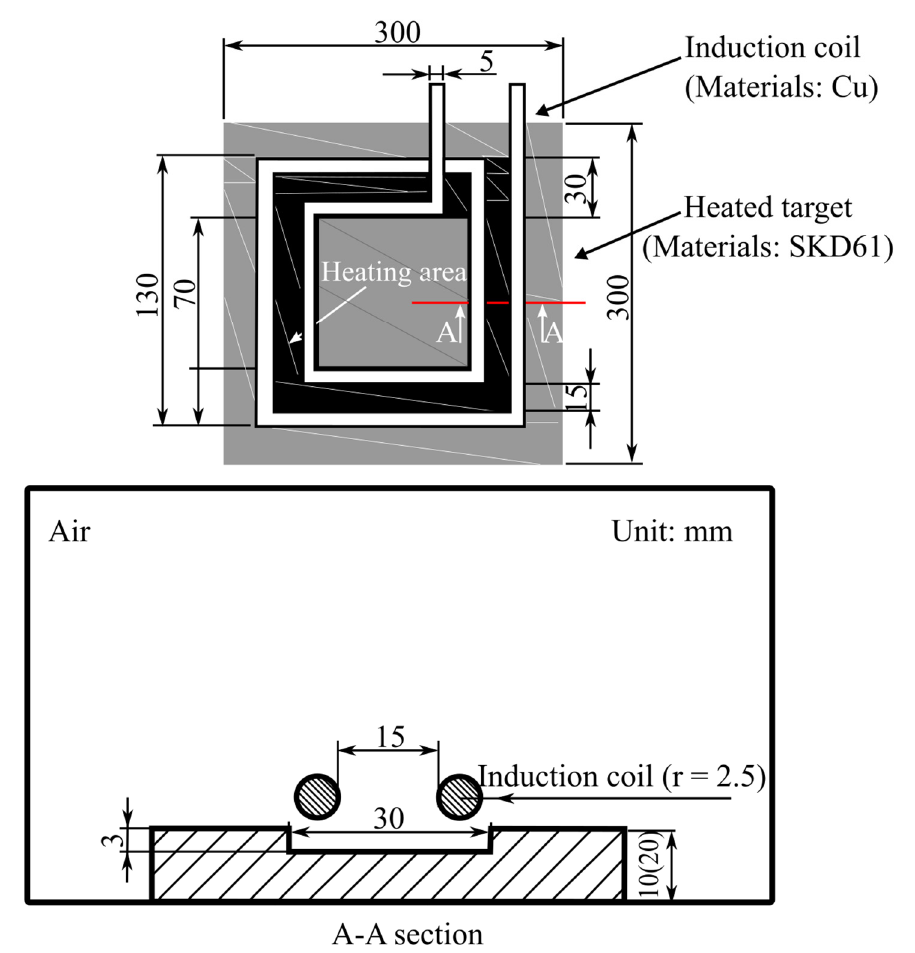
Figure 13. Physical model of induction heating [45].